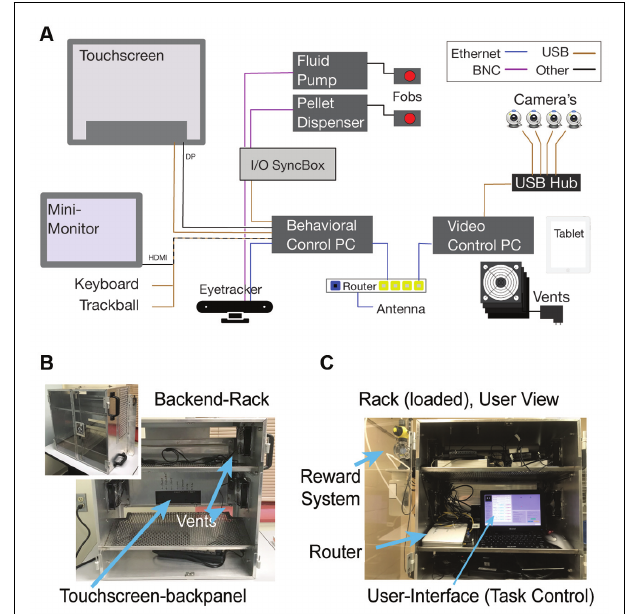
FIGURE 1 | Kiosk design and cage-mount. (A) Design drawing of the frame, front-end, and back-end of the Kiosk. The design is available as a CAD file online (see Appendix 1 ). (B) Front- and Back-end of the Kiosk Station mounted to a Primate Products Inc. apartment cage for rhesus monkeys. (C) Side-view of the mounted Kiosk which extends ∼ 23” from the cage. The side views show a small locked side door at the front end that enables reaching inside for cleaning the touchscreen. (D) Inside view onto the interface to the monkey shows the touchscreen, camera windows, sipper tube, and pellet receptacle. (E) Four monkeys (rows) interacting with the touchscreen as seen from the top and side camera window (camera windows A and B in panel D ). All monkeys maintain mouth contact with the sipper tube awaiting fluid reinforcement for their behavior ( left ) and use their fingers to touch objects displayed on the screen ( right ).